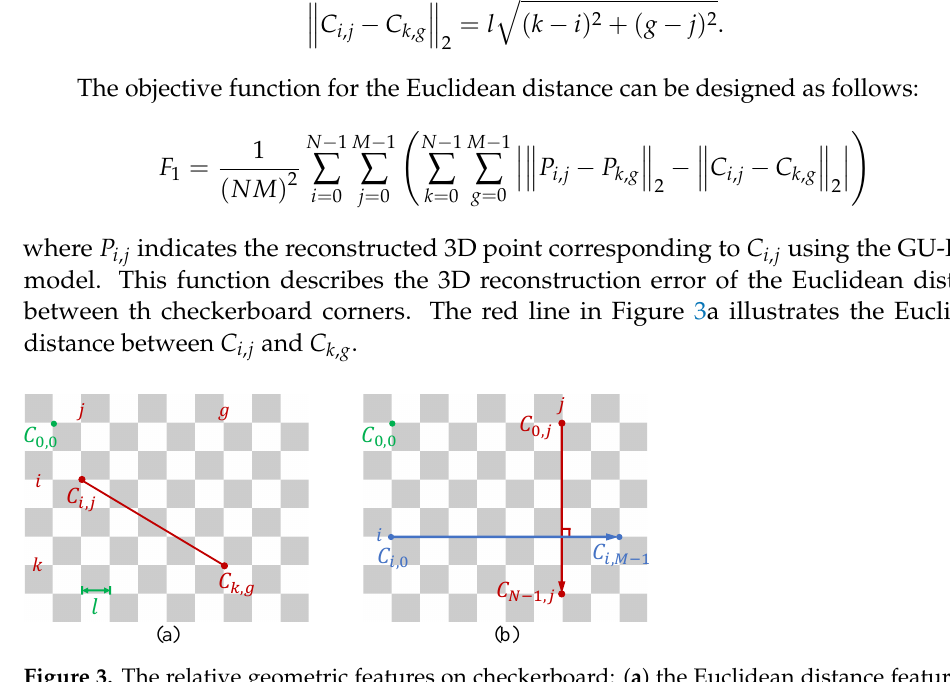
Figure 3. The relative geometric features on checkerboard: ( a ) the Euclidean distance feature and ( b ) the perpendicularity